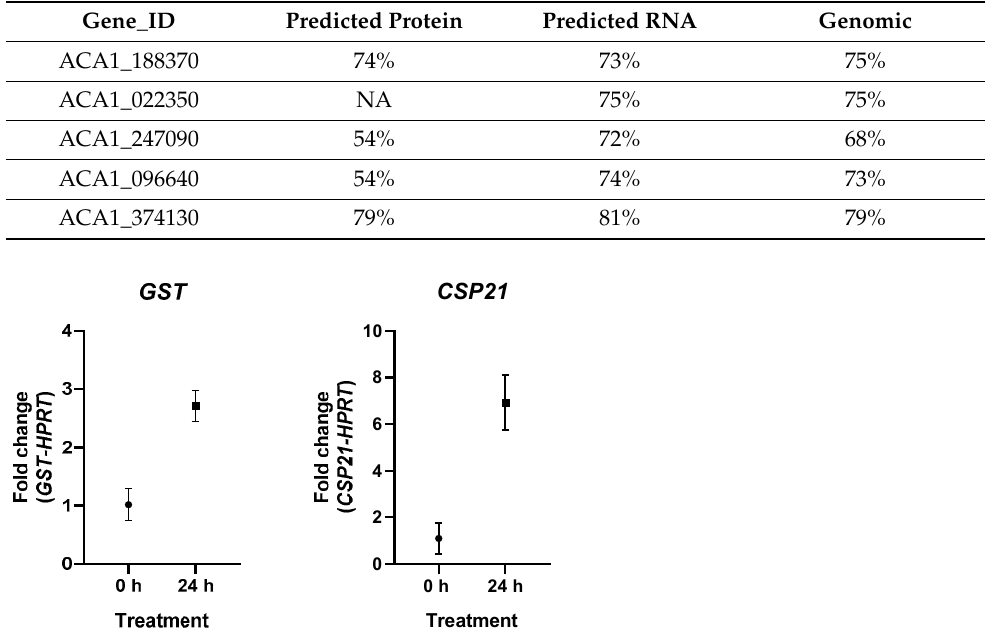
Figure 1. Differential expression of GST ( left ) and CSP21 ( right ) after 24 h of encystment stimulus. Each graph compares treatments at 0- and 24-h, representing fold change in expression; error bars represent standard error of the mean.